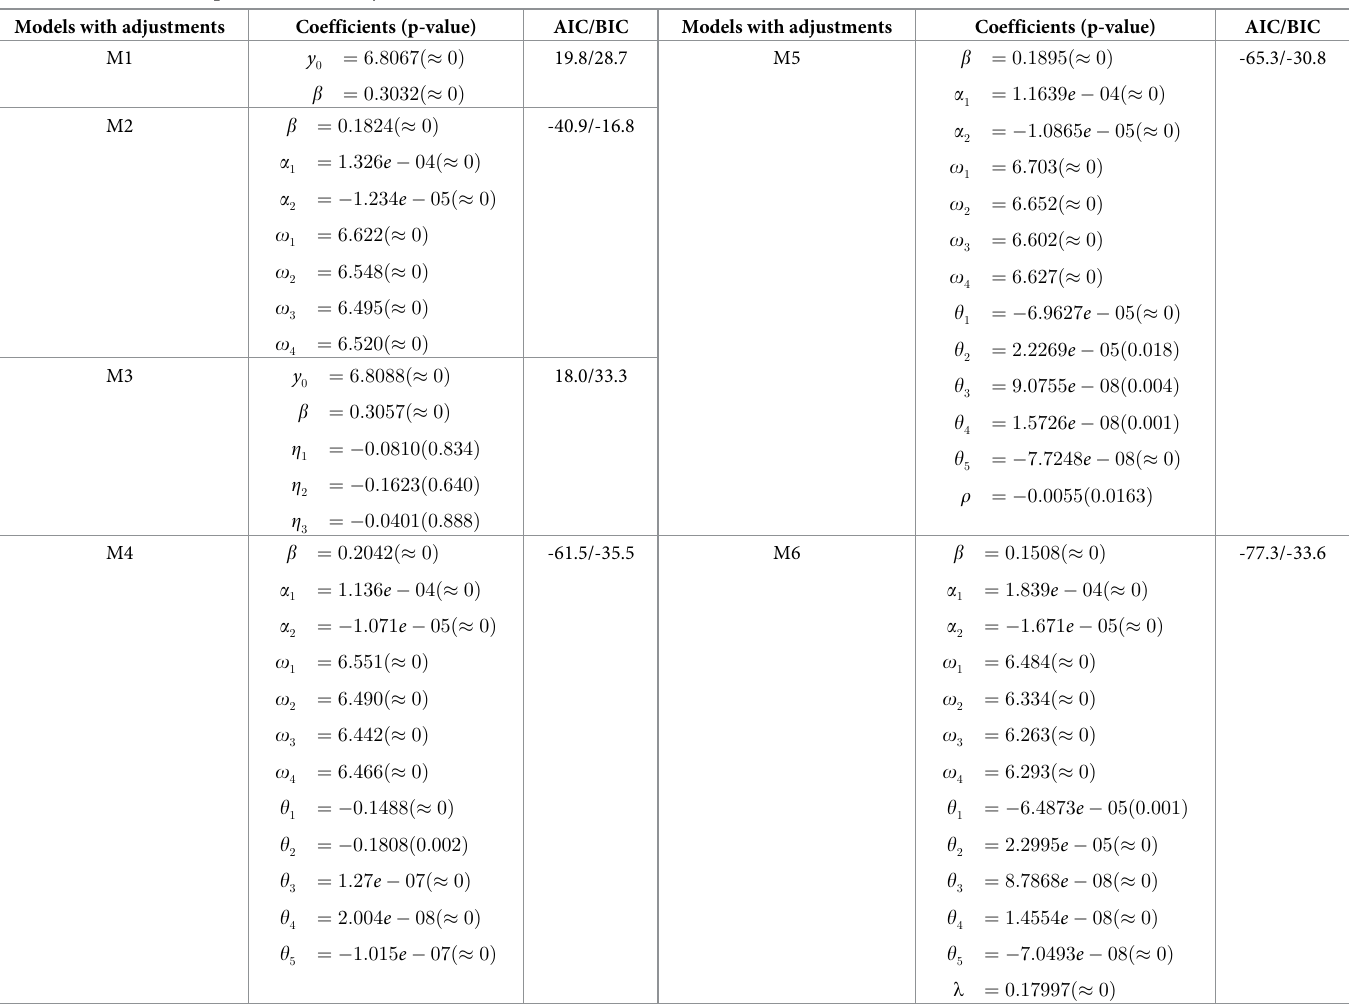
Table 3. Estimated model parameters with